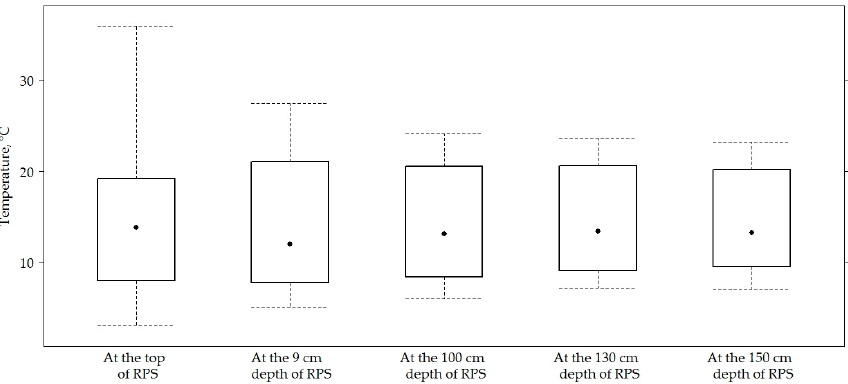
Figure 6. The box-plot of the measured temperature.